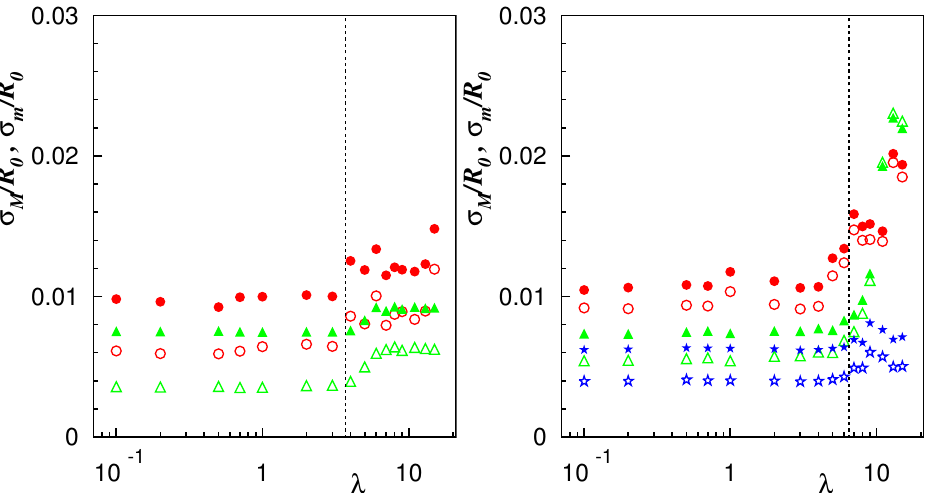
Figure 8. Rms fluctuation values σ M (filled symbols) and σ m (empty symbols) of the the gyration tensor eigenvalues of Figure 7 as a function of λ at S ∗ = 0.80 ( left ) and S ∗ = 0.95 ( right ) for κ / ( k B TR 0 ) = 6.58 ( • ), 65.8 ( (cid:78) ), 164.5 ( (cid:63) ). The tank-treading to tumbling transition in the Keller– Skalak theory [5] is marked by the dashed vertical lines.